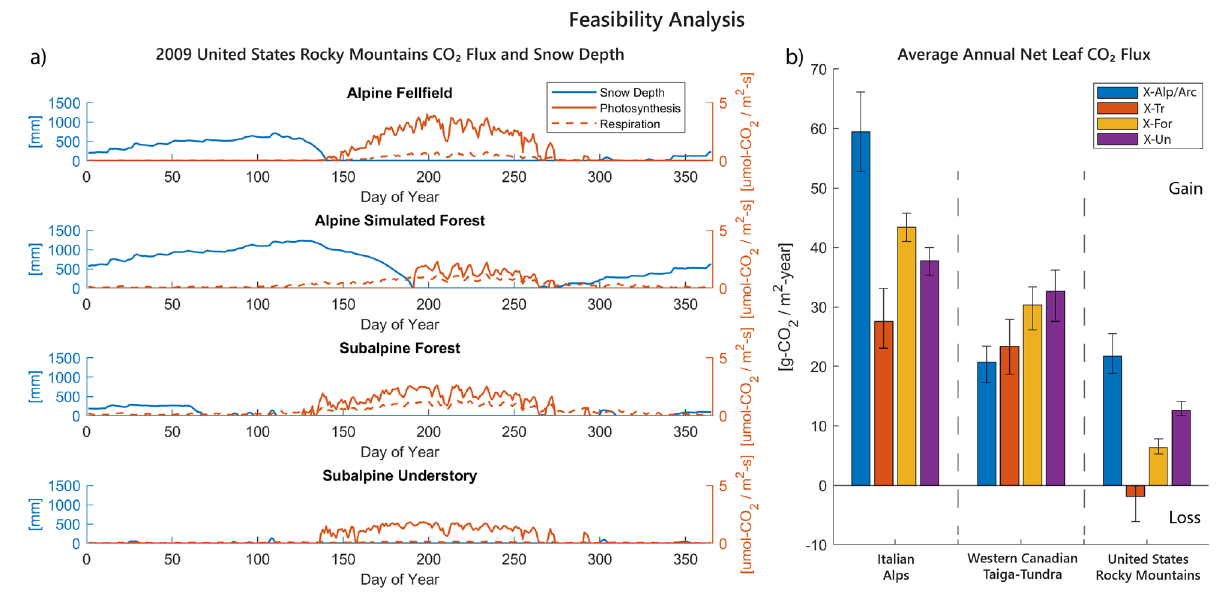
Figure 5. Feasibility analysis demonstrating annual net loss of CO 2 flux for the United States Rocky Mountains alpine simulated forest counterfactual scenario due to increased snowpack and shortened growing seasons. ( a ) 2009 daily timeseries of modeled snow depth ( blue ) and leaf CO 2 flux—the averaged daily photosynthetic CO 2 uptake ( orange solid line ) and above-ground autotrophic respiration ( orange dotted line )—for the United States Rocky Mountains scenarios. For the alpine simulated forest, cooler temperatures near the earth’s surface result in faster accumulation of snow and less snowmelt throughout the winter, extending the time needed to melt the snow. Thus, the simulated forest exhibits compounding snow depth and an abbreviated summer season without snowpack, leading to shortened photosynthesis periods compared to the alpine fellfield scenario ( top panel ). ( b ) Modeled average annual net leaf CO 2 flux over the entire study period (IT, 2 years; CA, 3 years; US, 6 years). Positive flux corresponds to net leaf uptake (i.e., photosynthesis minus above-ground autotrophic respiration). Error bars indicate the range of annual net leaf CO 2 flux for all years of the study period. Simulated forests for the two alpine sites ( orange ; US-Tr & IT-Tr) experience decreases in net CO 2 flux compared to the other scenarios. Further, the US-Tr scenario exhibits overall losses in CO 2 year to year, creating unsustainable mass balance for biomass productivity and indicating that the counterfactual is